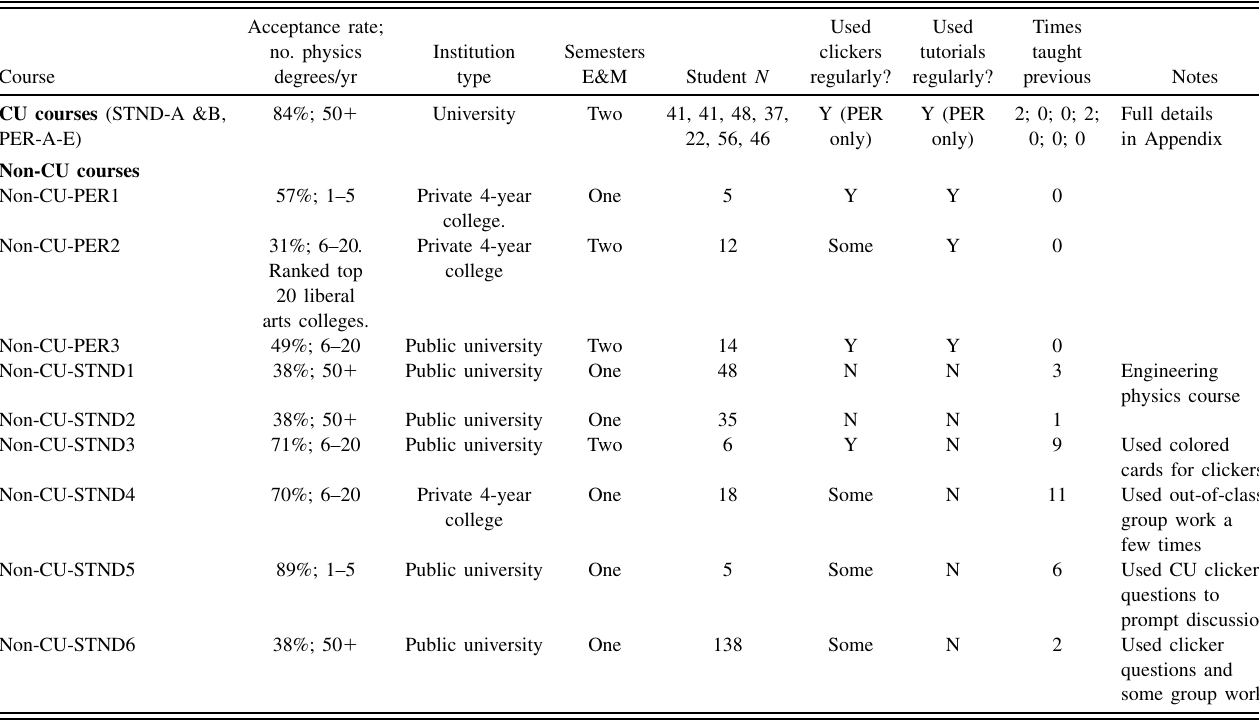
TABLE I. Courses included in the CUE results. Fall 2009 acceptance rate for each university obtained from Ref. [35] with the exceptions of Non-CU-STND1, Non-CU-STND2, and Non-CU-STND6—a Canadian institution; that admission rate represents the number of students admitted to their first-choice program (compared to the number of applicants to first-choice programs), offering a measure of selectivity. ‘‘No. physics degrees’’ represents the number of undergraduate degrees awarded by the department, per year. The remaining course data were obtained directly from instructors. ‘‘Semesters E&M’’ indicates whether the course in question represents a single semester encompassing both electrostatics and electrodynamics (‘‘One’’) or whether it was the first semester of a two-semester E&M sequence (‘‘Two’’). ‘‘Student N ’’ represents the number of students who took the CUE and did not drop the course. ‘‘Regularly’’ is defined as several times a week for clickers, and at least once a week for tutorials. ‘‘Some’’ clicker use is defined as using clickers, but less than once per